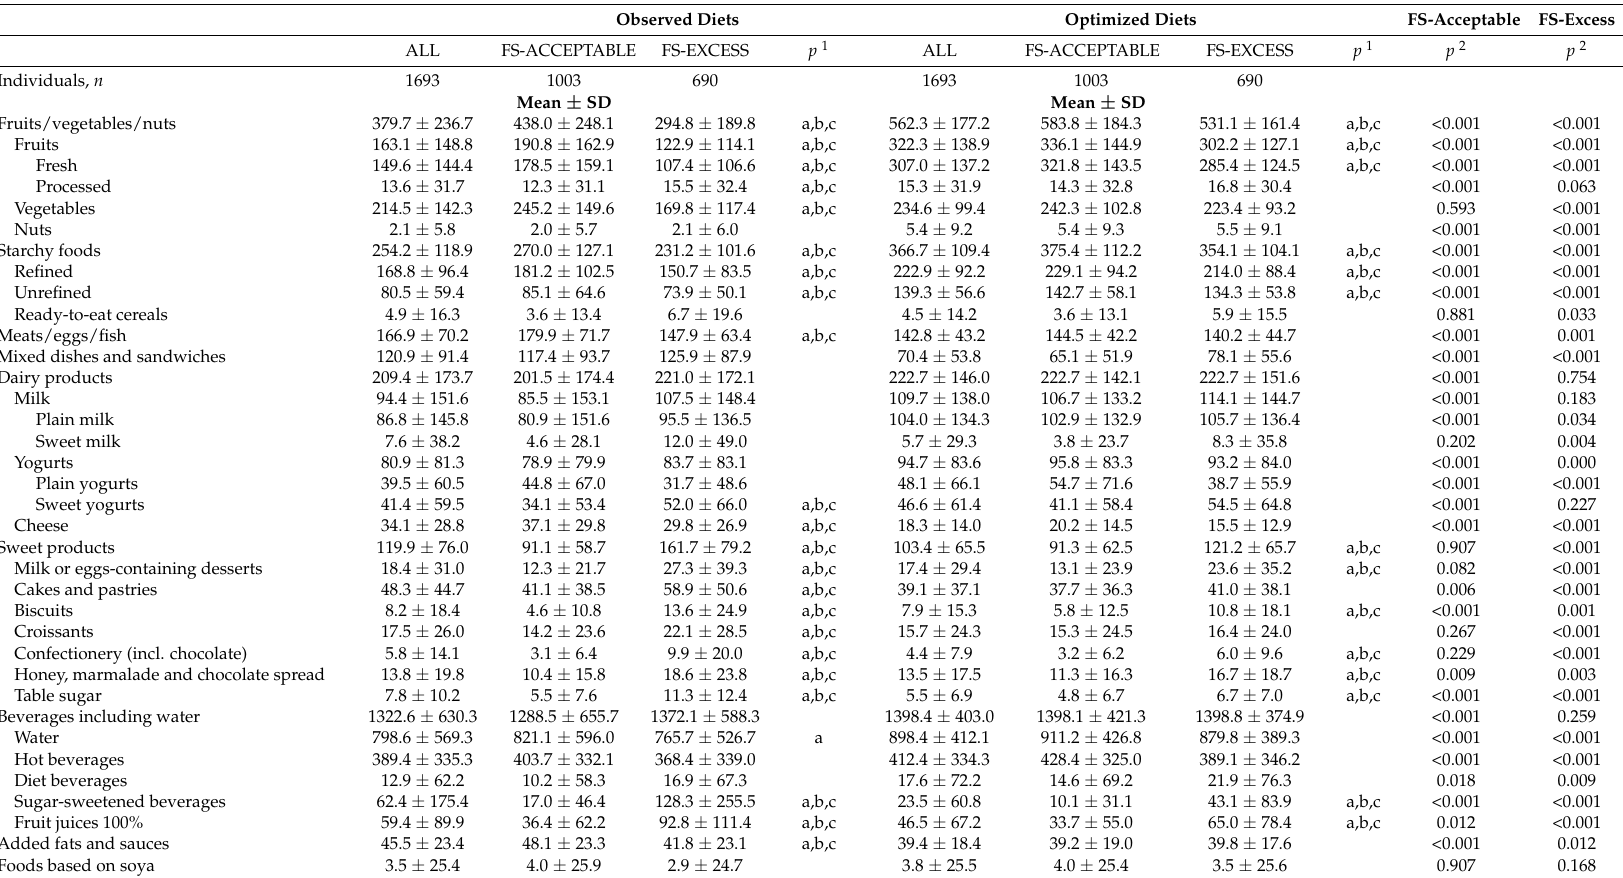
Table 3. Amounts of food categories and sub-categories in observed and optimized diets for the total sample and for FS-ACCEPTABLE and FS-EXCESS groups (g/day). Observed Diets Optimized Diets FS-Acceptable FS-Excess ALL FS-ACCEPTABLE FS-EXCESS p 1 ALL FS-ACCEPTABLE FS-EXCESS p 1 p 2 p 2 Individuals,